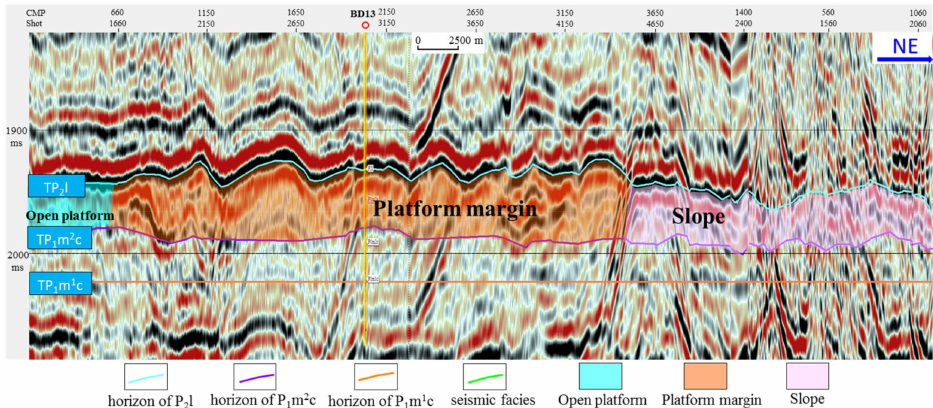
Figure 15. Platform margin deposition of Maokou Formation in Eastern